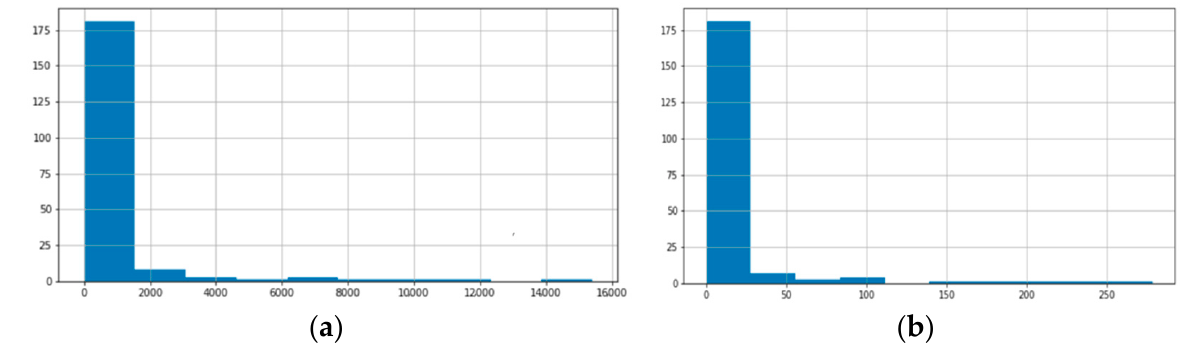
Figure 1. Histogram of ( a ) the houses damaged and ( b ) deaths.